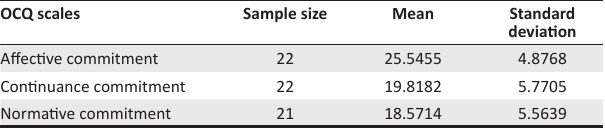
TABLE 3: Summary statistics, JS – Smith et al. (1969) JDI. JDI scales